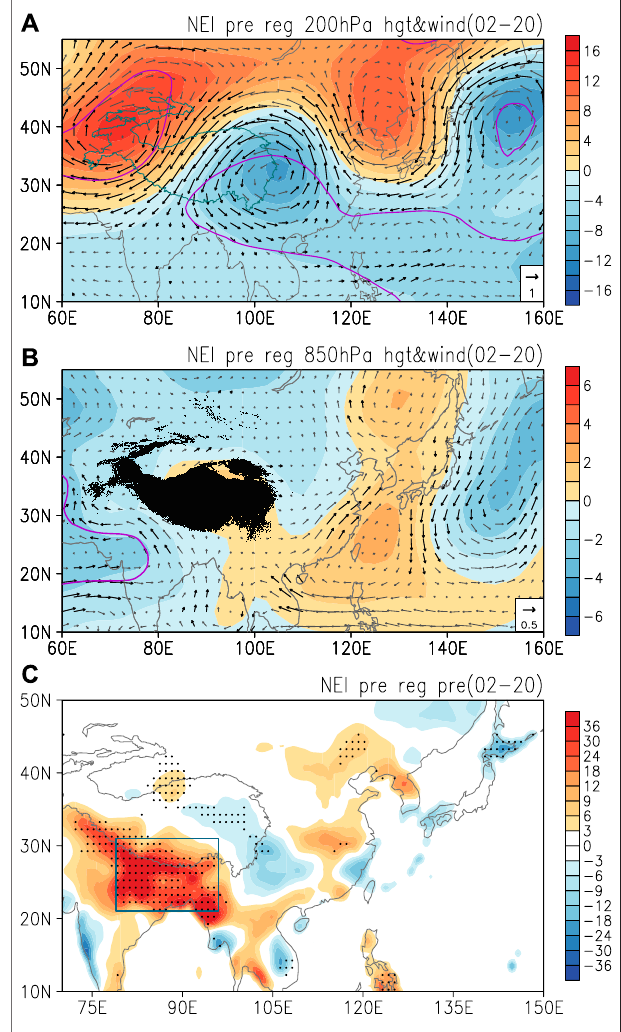
FIGURE 5 | Anomalies of (A) 200 hPa and (B) 850 hPa geopotential height (hgt) (shading, gpm) and wind (vector, m/s) in summer obtained by linear regression against the northeast Indian summer precipitation index for the period 2002 — 2020. (C) Anomalies of summer precipitation (pre) (mm/month) obtained by linear regression against the northeast Indian summer precipitation index for the period 2002 — 2020. The scale for winds is shown at the bottom-right corner. The black vectors in (A, B) denote wind anomalies signi fi cant at the 95% con fi dence level. The purple contours in (A, B) denote geopotential height anomalies signi fi cant at the 95% con fi dence level. The dotted regions in (C) denote precipitation anomalies signi fi cant at the 95% con fi dence